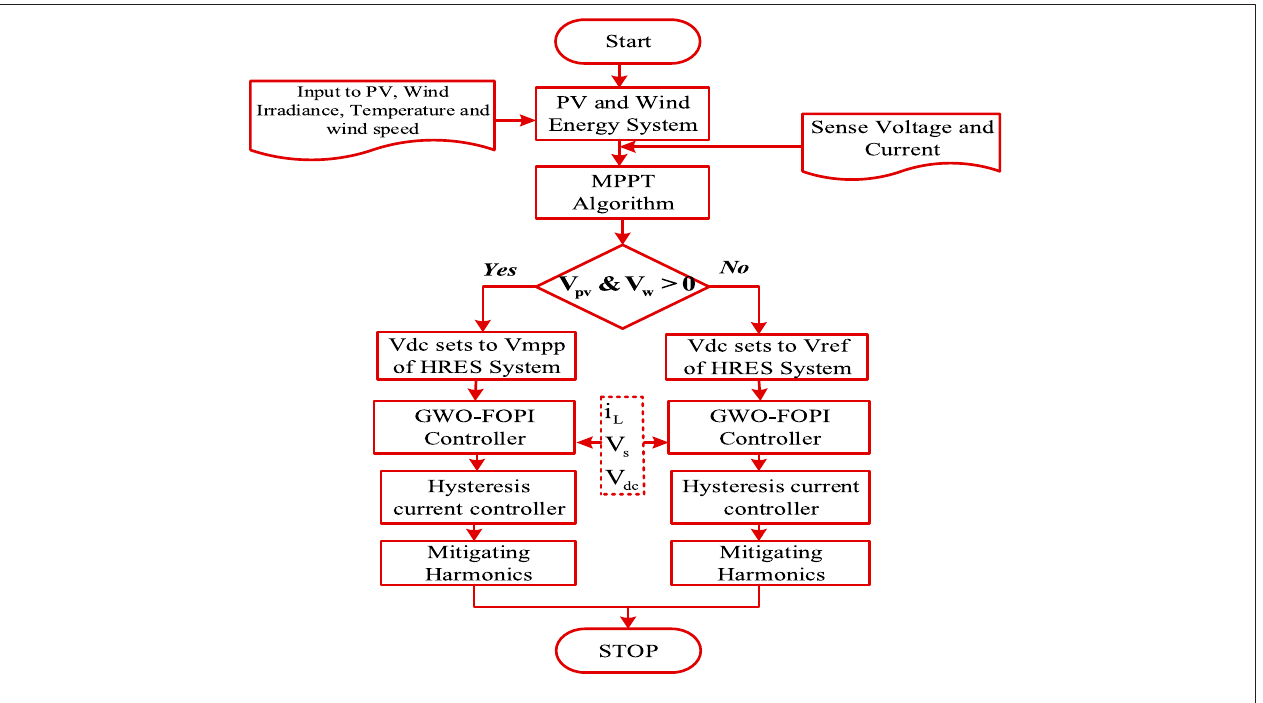
FIGURE 1 | Flow chart of the proposed